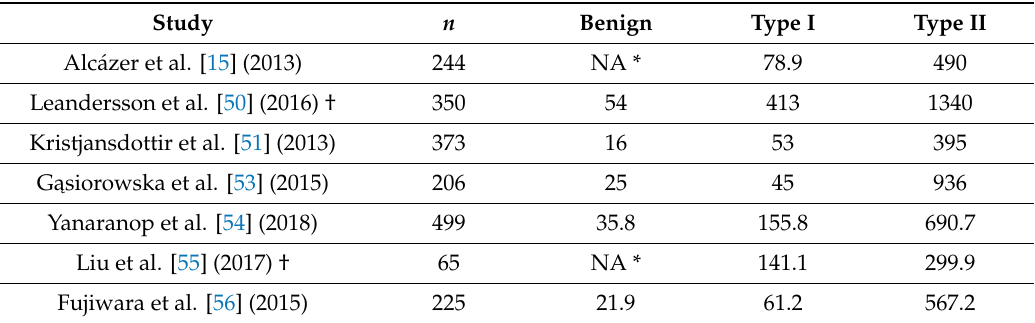
Table 2. Median CA125 levels (U / mL) in women with benign adnexal masses, type I, and type II ovarian